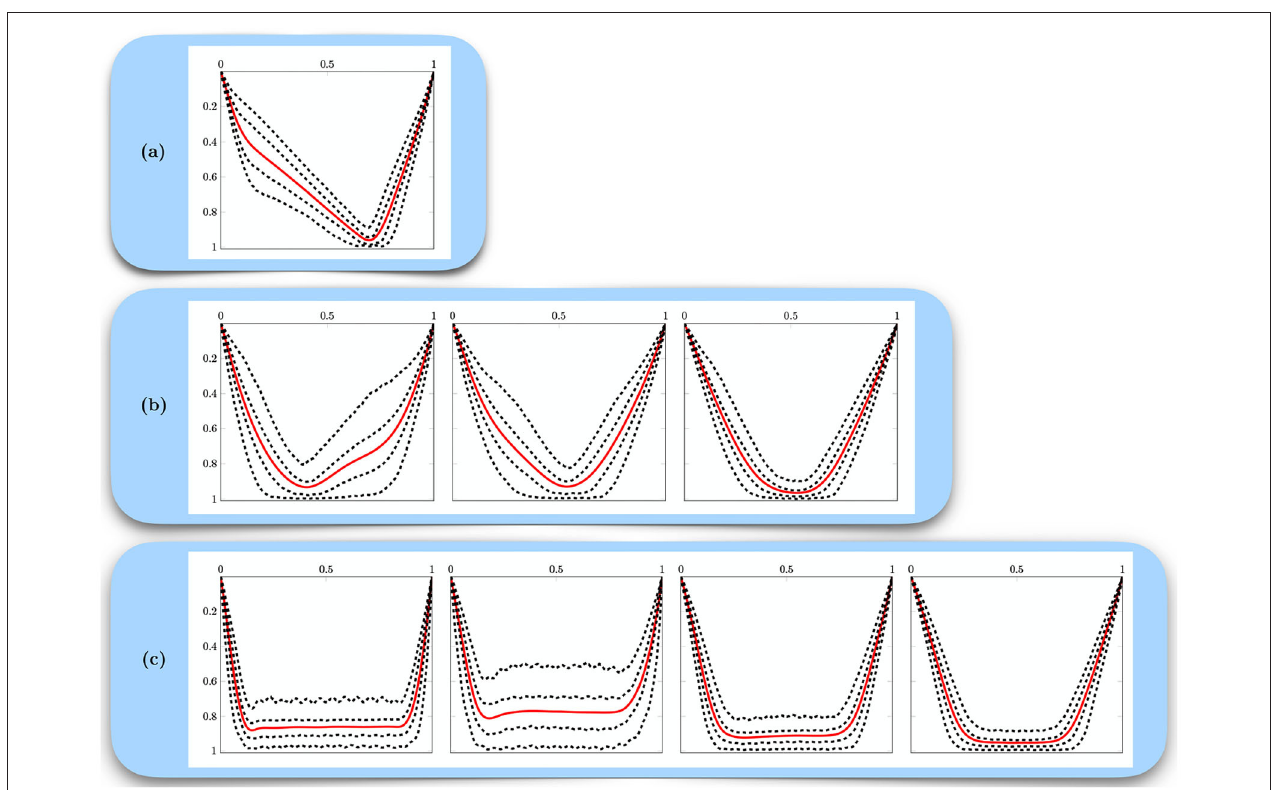
FIGURE 9 | The different clusters of dives. The 2.5, 25, 75, and 97.5 % quantile curves are in black dotted lines. Cluster mean curves are in solid red lines. The three categories are (a) drift, (b) exploratory, and (c) active according to the literature. Clusters in category (c) are sorted according to decreasing mean time spent at the